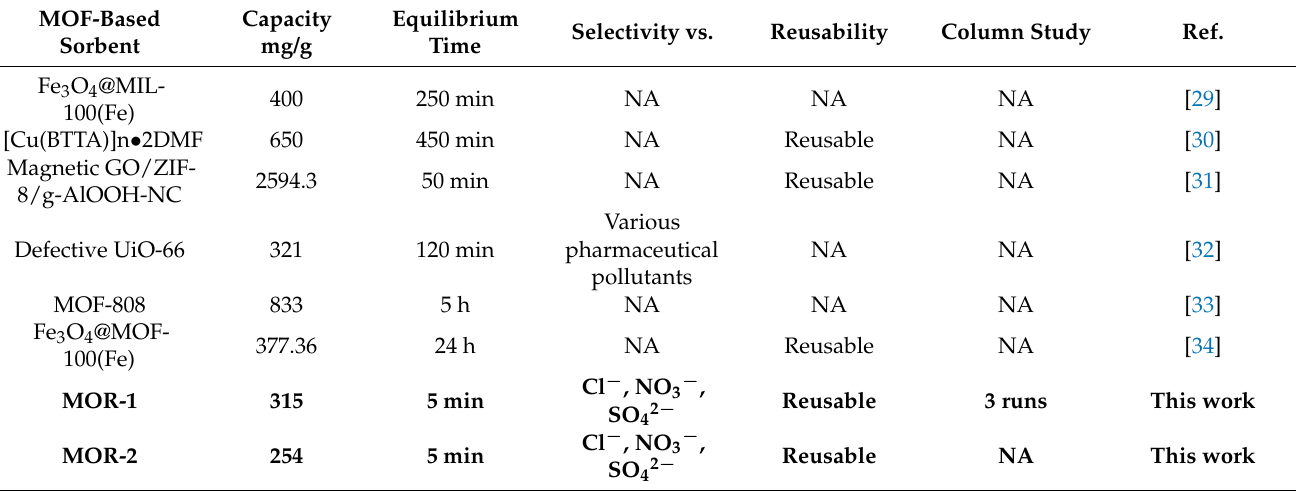
Table 3. Comparison of the sorption characteristics of MOR-1 and MOR-2 with those of other MOF-based